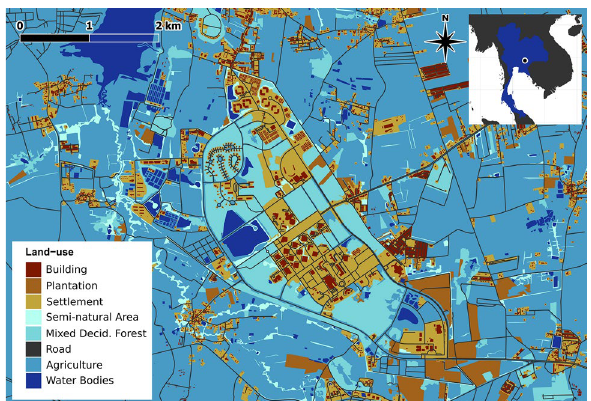
Figure 1. Study site map illustrating the land-use types spanning the area where the Malayan kraits ( Bungarus candidus ) were tracked in Muang Nakhon Ratchasima, Nakhon Ratchasima province, Thailand. Map